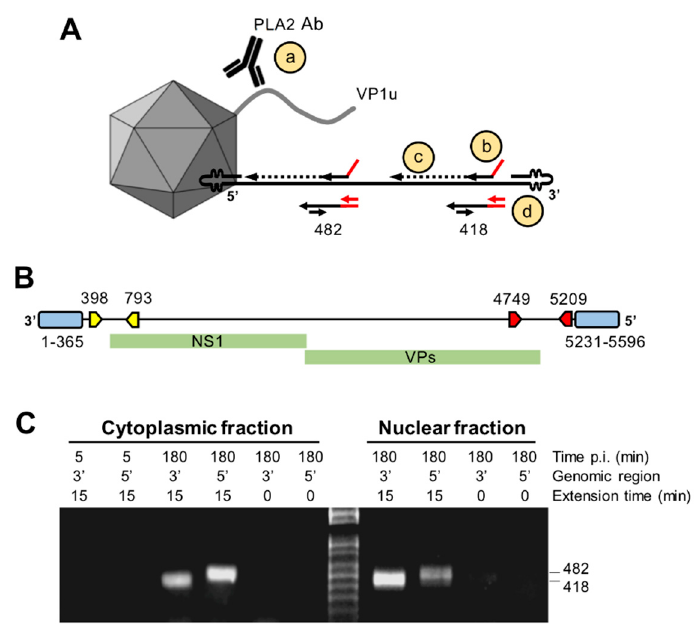
Figure 8. Complementary-strand DNA synthesis from cytoplasmic or nuclear capsids. ( A ) Depiction of the strategy for complementary-strand synthesis: ( a ) Immunoprecipitation of B19V capsids with the PLA2 antibody; ( b ) 5’ virus-unrelated sequence; ( c ) extension reaction by T7 polymerase at 37 °C; and ( d ) amplification of the primer-extended DNA by PCR. ( B ) Positions in the B19V genome of the 3’ (yellow) and 5’ (red) regions targeted by the hybridization and extension assay. ( C ) Viral particles were immunoprecipitated from cytoplasmic or from nuclear fractions with the antibody against the PLA 2 region (PLA2) and used for complementary-strand DNA synthesis. The primer-extended DNA was amplified by PCR and amplicons of the expected size were visualized by agarose gel electrophoresis. As controls, viruses were immunoprecipitated 5 min pi or incubated with the T7 polymerase for only a few seconds.